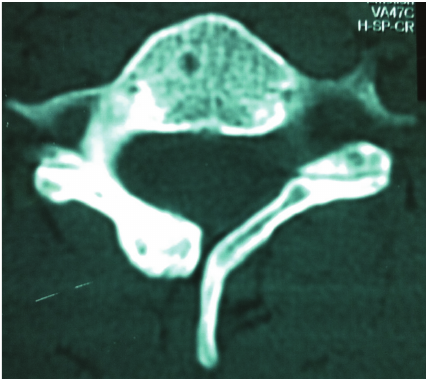
Figure 1: CT image of the lesion. Lamina bifida of C5 and the expansile sclerotic lesion on it are seen.